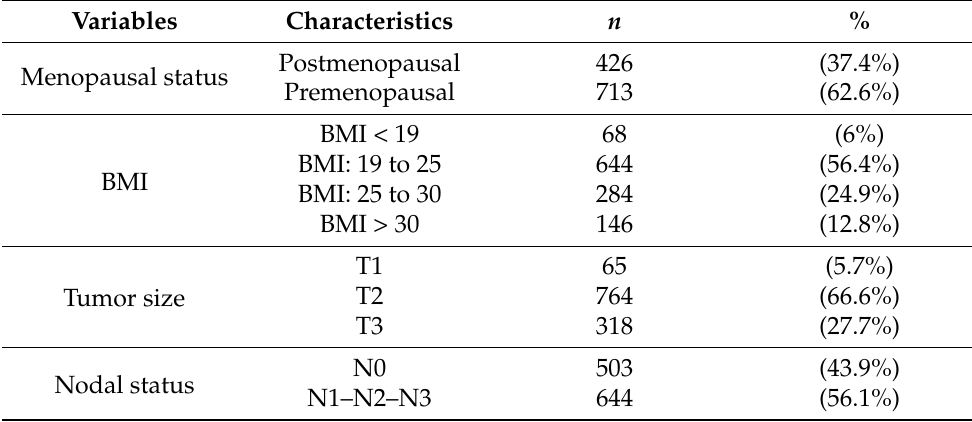
Table 1. Patients and tumor characteristics before neoadjuvant chemotherapy